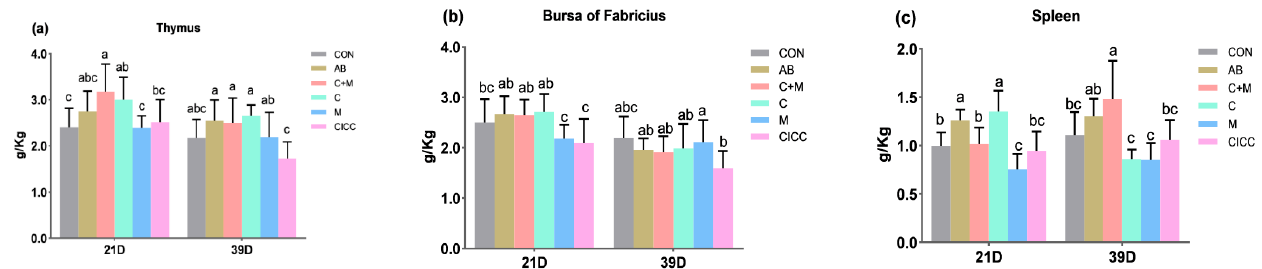
Figure 1. Effect of Bacillus amyloliquefaciens LFB112 on immune organ index (g/kg) of broilers. ( a ) Effect of Bacillus amyloliquefaciens LFB112 on thymus. ( b ) Effect of Bacillus amyloliquefaciens LFB112 on bursa of Fabricius. ( c ) Effect of Bacillus amyloliquefaciens LFB112 on spleen. Experimental groups assigned were as follows: CON = basal diet; AB (antibiotics) = basal diet + aureomycin 150 mg/kg; C + M = basal diet + LFB112 fermentation dry powder with Bacillus cells + metabolites (5 × 10 8 CFU/g); C = basal diet + LFB112 Bacillus cells powder with removed metabolites (5 × 10 8 CFU/g); M = basal diet + LFB112 metabolite powder with removed Bacillus cells (5 × 10 8 CFU/g); CICC = basal diet + Bacillus subtilis 20 , 179 (5 × 10 8 CFU/g). (a–c) Different letters on standard error bars indicate a significant difference ( p < 0.05). Data are shown as means and standard errors ( n = 6).